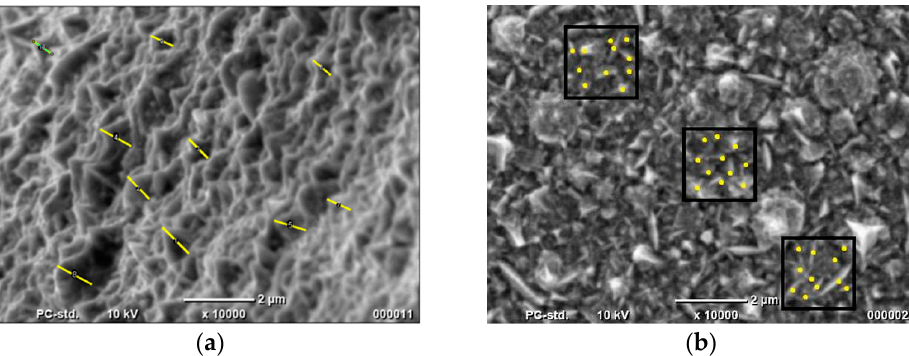
Figure 3. Determination of ( a ) cones height and ( b ) number of cones using SEM photos.